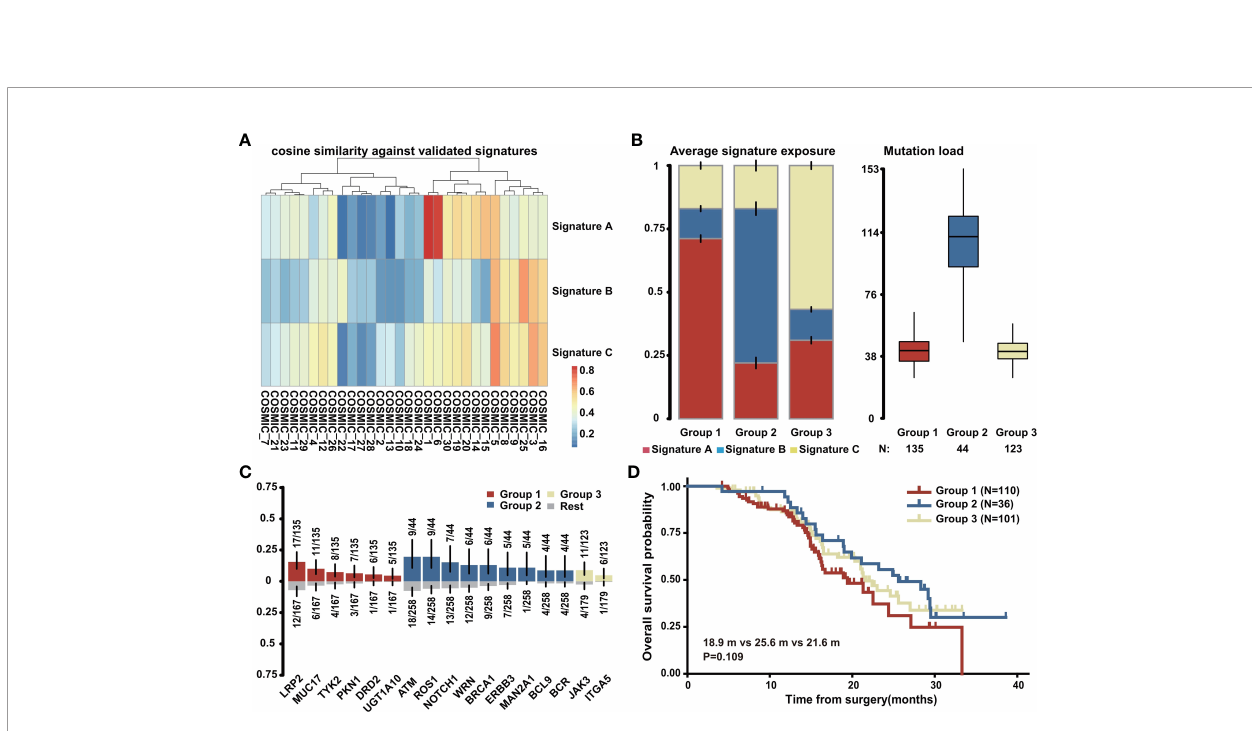
FIGURE 3 | Mutational signature of PDAC. (A) The correlation between three identi fi ed mutational signatures in PDAC (n = 302) and reported COSMIC signatures. (B) Three groups of PDAC patients (n = 302) classi fi ed by average signature exposure (left) and their mutation load (right). (C) Speci fi c gene mutations enriched in the three groups (n = 302). (D) Overall survival analysis of the three groups with PDAC patients who received radical resection and had complete follow-up data (n = 247).